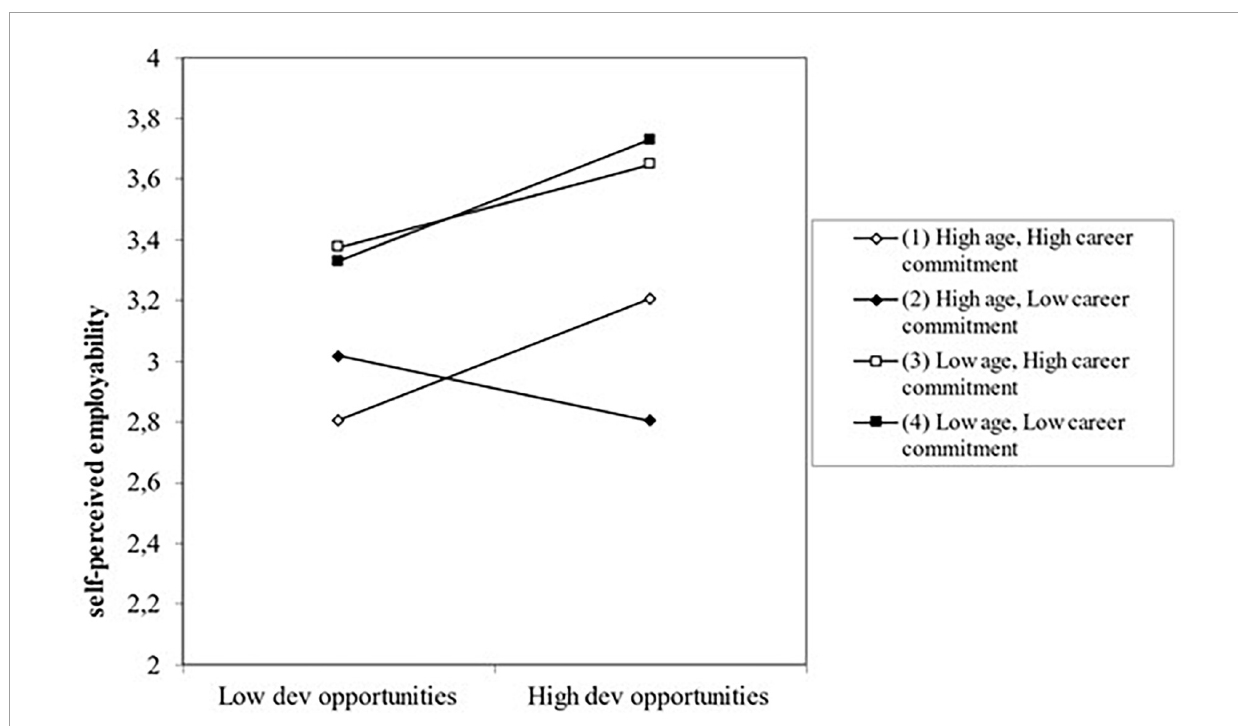
FIGURE3 Three-way interactive effect of developmental opportunities with career commitment and with age for self-perceived employability.